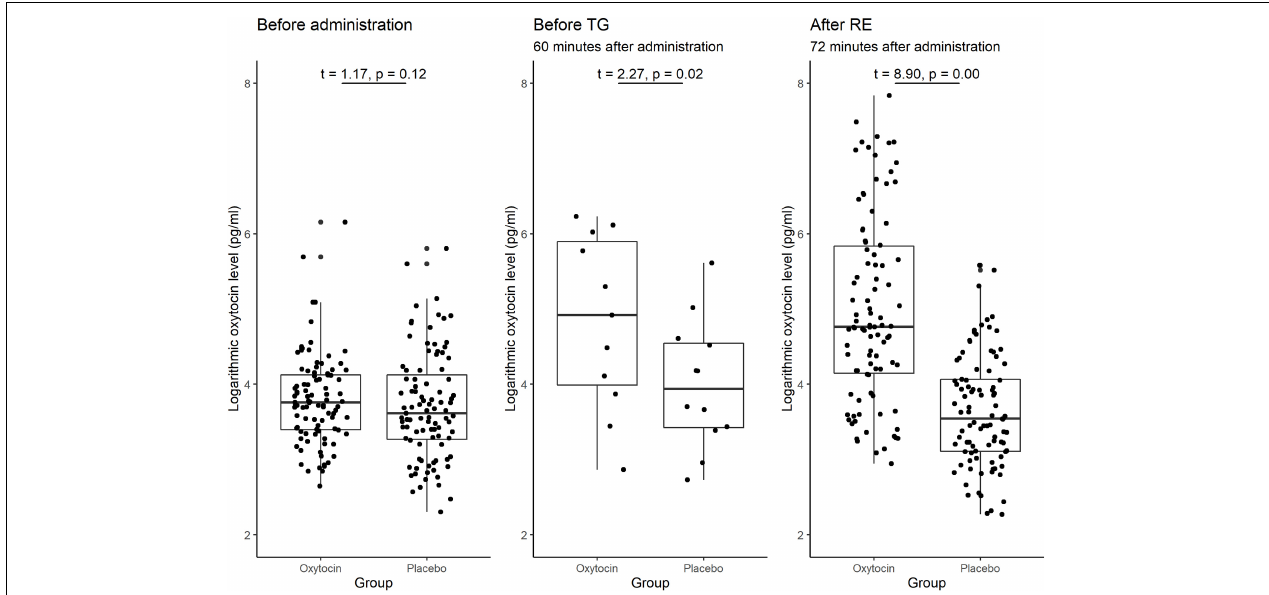
FIGURE 7 | Box plots of oxytocin concentrations at different time points in the oxytocin and placebo groups. For each plot, the middle horizontal line denotes the median value; the box extends from the 25th to the 75th percentile values; the vertical lines extending from the box denotes adjacent values (i.e., the most extreme values within 1.5 interquartile of the 25th and 75th percentile of each group); and the dots denote the oxytocin concentration per investor. The sample size for the time point before the trust game (TG) was small ( n = 12), as we measured this concentration only for the last experimental session. The oxytocin concentration in the oxytocin group increased immediately after administration and remained elevated until the end of the experiment. The difference in the average oxytocin concentration before administration vs. after the risk experiment (RE) was significant for the oxytocin group [ t ( 95 ) = 8.97, P < 0.01, one-sided], but not for the placebo group [ t ( 95 ) = − 1.53, P = 0.94, one-sided]. The differences in the oxytocin concentrations before the TG vs. after the RE were not significant in either the oxytocin group [ t ( 11 ) = − 2.41 P = 0.98, one-sided] or the placebo group [ t ( 11 ) = − 1.22, P = 0.88, one-sided]. The difference in the oxytocin concentrations before administration vs. before the TG was significant in the oxytocin group [ t ( 11 ) = 2.55, P = 0.01, one-sided], but not in the placebo group [ t ( 11 ) = 1.38, P = 0.10,